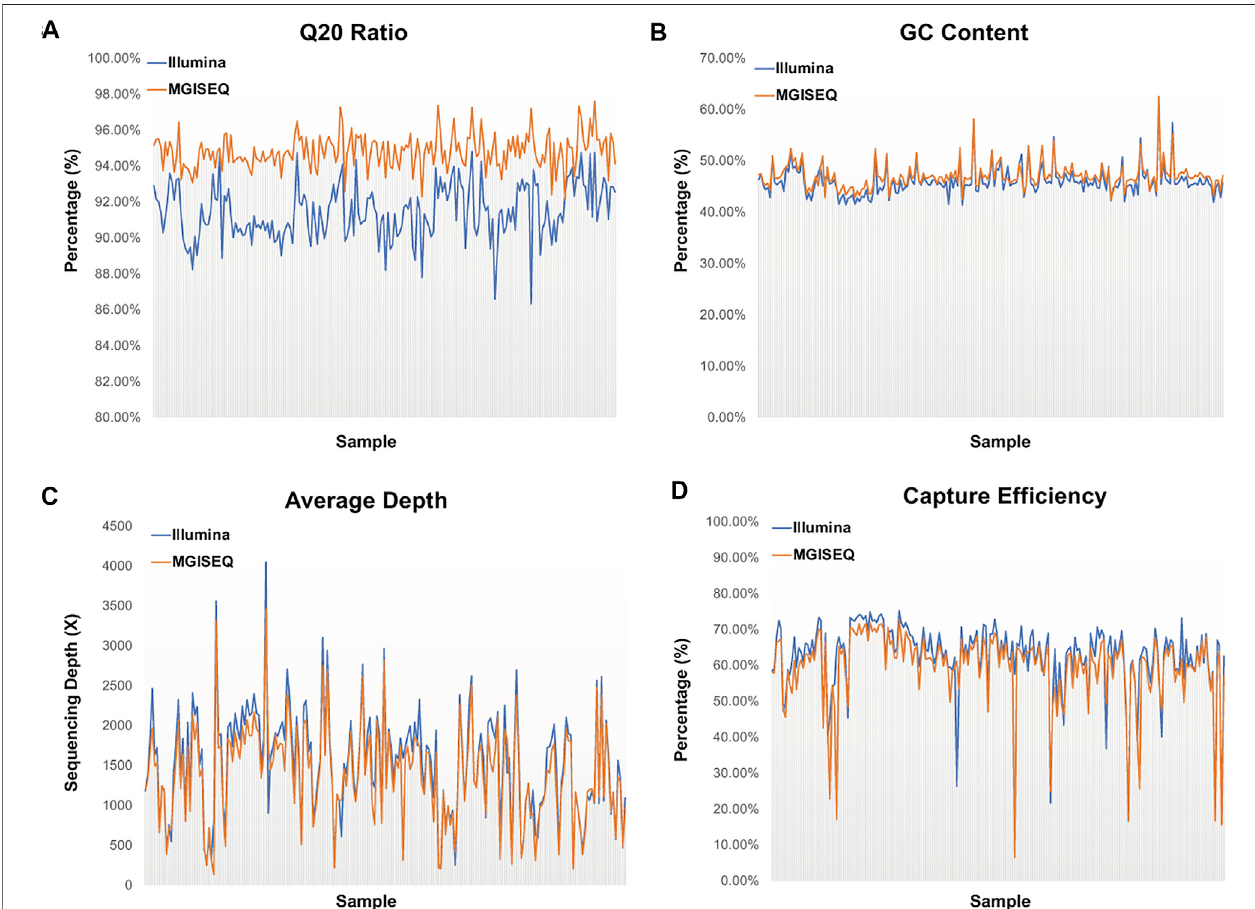
FIGURE 1 | Comparison of Sequencing Data Quality Control Parameters between Illumina and MGISEQ-2000 Platforms. (A) Distribution of Q20 ratio by each sample. (B) Distribution of GC content by each sample. (C) Distribution of average depth by each sample. (D) Distribution of probe capture ef fi ciency by each sample.